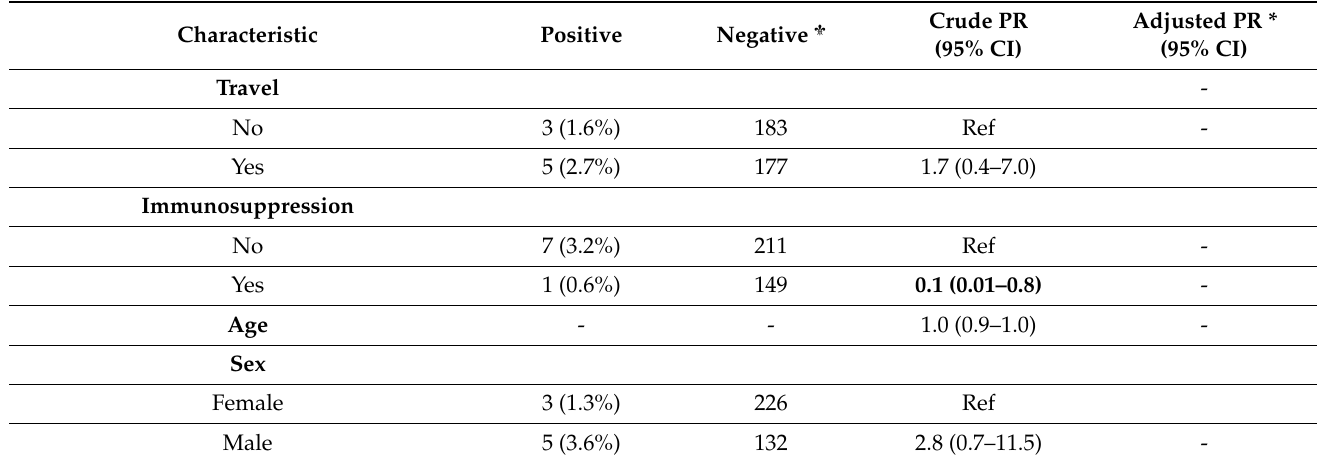
Table 4. Cont. Table 4. Risk factors for latent tuberculosis infection (LTBI) and Strongyloidiasis.